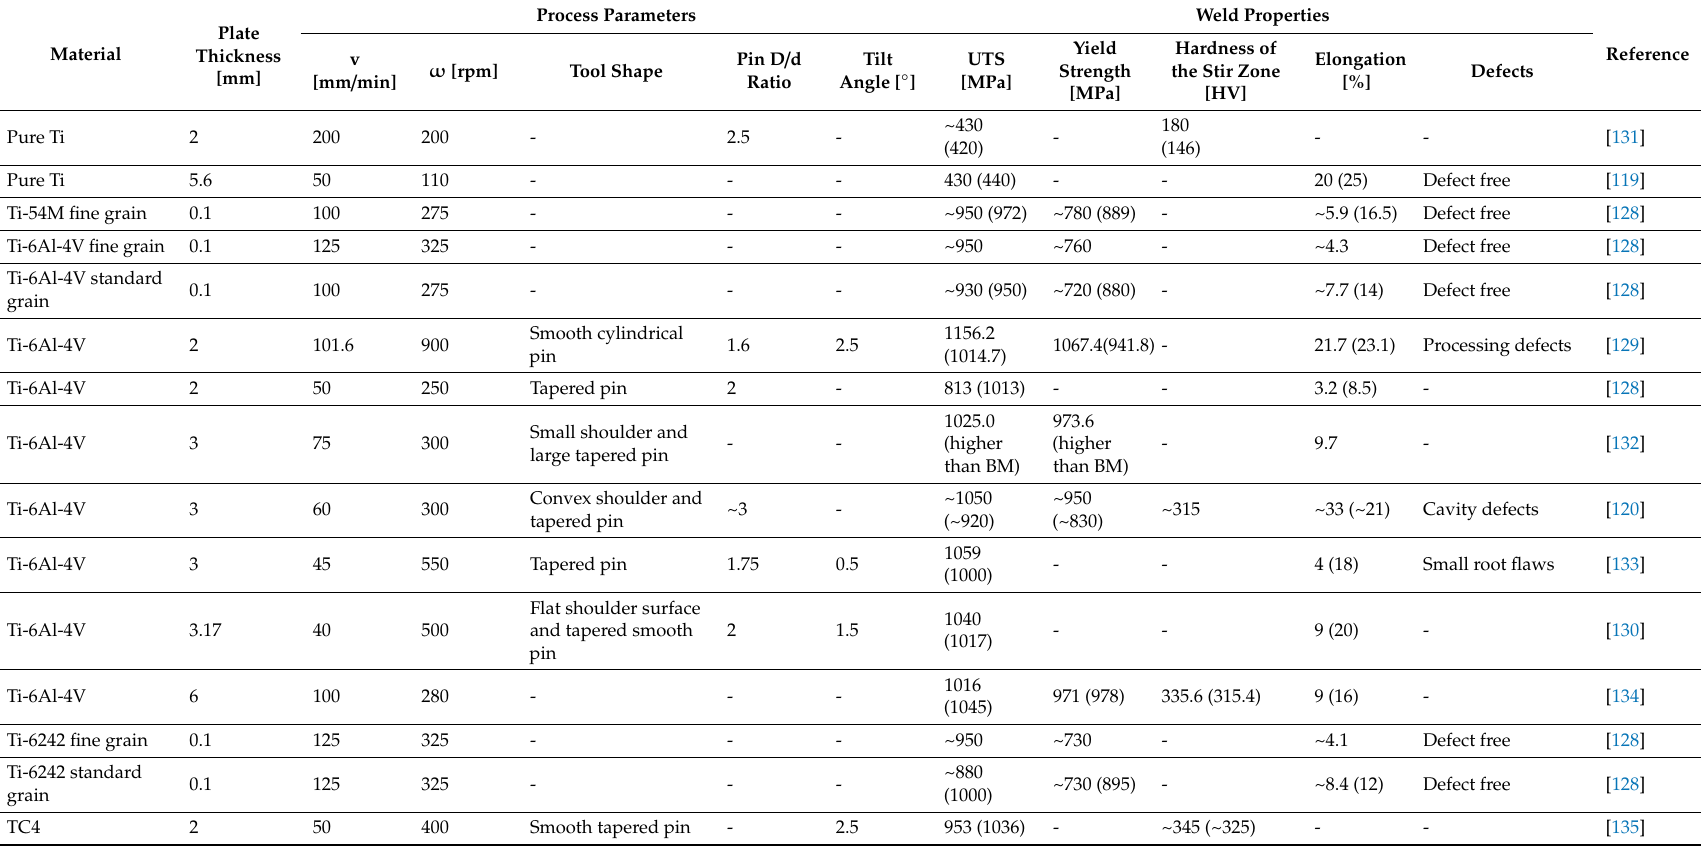
Table 4. FSW of titanium and its alloys—process parameters and mechanical properties of the